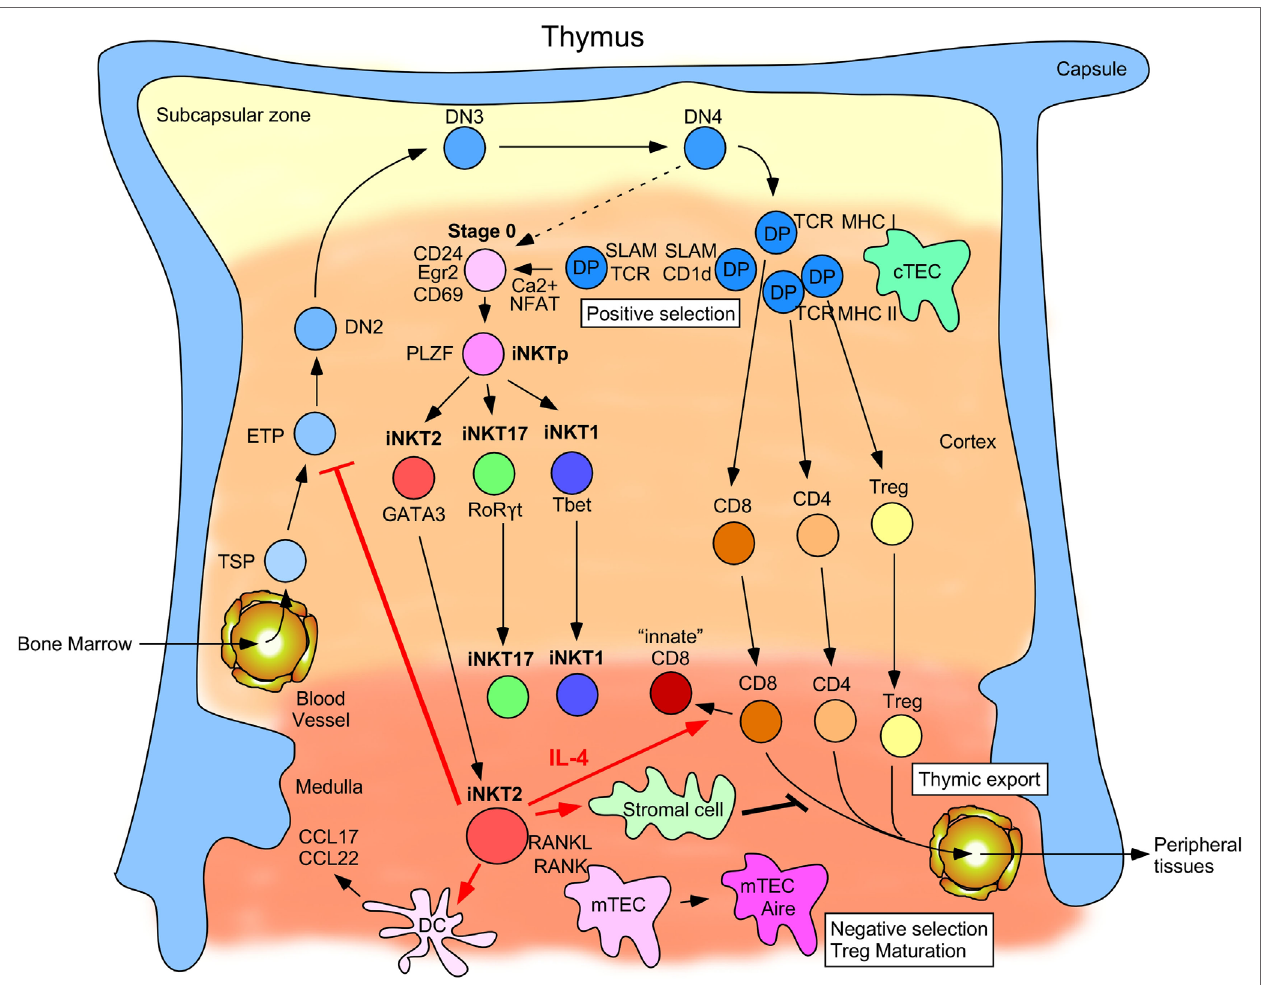
FigURe 1 | Schematic describing invariant natural killer T (iNKT) cell development and function in the thymus. Thymus-settling progenitors emigrate from the bone marrow and then mature into early thymic progenitors and progressively commit to the T cell lineage by maturing from the double negative 2 cell stage to DN3, DN4, and eventually to the double-positive (DP) cell stage. Here, they begin to rearrange their TCR α loci and can then be selected by MHC-I- and MHC-II-expressing cortical thymic epithelial cells (cTECs). Cells that successfully undergo positive selection by cTECs can become immature CD8 + , CD4 + , and T reg cells. By contrast, a small proportion of DP cells rearranges its TCR α locus to generate the iNKT α chain and is selected by other DP cells expressing CD1d and signaling lymphocytic activated molecules family receptors. Intracellular calcium levels are high in these post-selected stage 0 cells, which leads to NFAT translocation into the nucleus and upregulation of Egr2 and CD69. An alternative pathway (depicted by a dashed arrow) wherein a small number of DN4 thymocytes rearrange their TCR α loci to generate the iNKT α chain that can then give rise to stage 0 iNKT cells upon positive selection has also been described. These cells then transition through an uncommitted PLZF hi stage before diverging into the functionally distinct iNKT2, iNKT17, and iNKT1 subsets defined by the transcription factors GATA-3, ROR γ t, and T-bet, respectively. iNKT2 cells migrate from the cortex to the medulla where they begin to produce IL-4 at steady-state. This IL-4 production (as designated by red arrows) has been linked to conditioning surrounding CD8 + T cells to become innate-memory CD8 + T cells, promoting certain dendritic cell populations to secrete the chemokines CCL17 and CCL22, preventing ETP commitment to the T cell lineage and inhibiting thymic export of single positive (SP) thymocytes into peripheral tissues. RANKL expressed by medullary iNKT2 (and iNKT17) cells also promotes maturation of medullary thymic epithelial cells (mTECs) into Aire + MHC-II hi mTECs, which mediate negative selection of medullary SP thymocytes and T reg